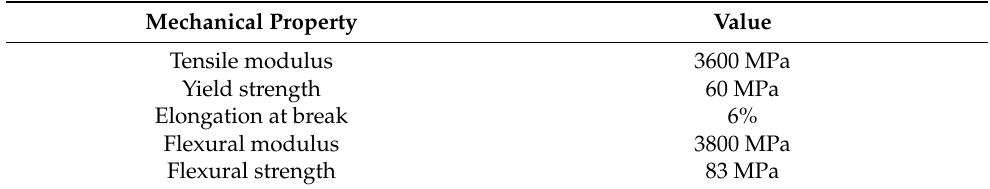
Table 1. Polylactic acid (PLA) mechanical properties [20].